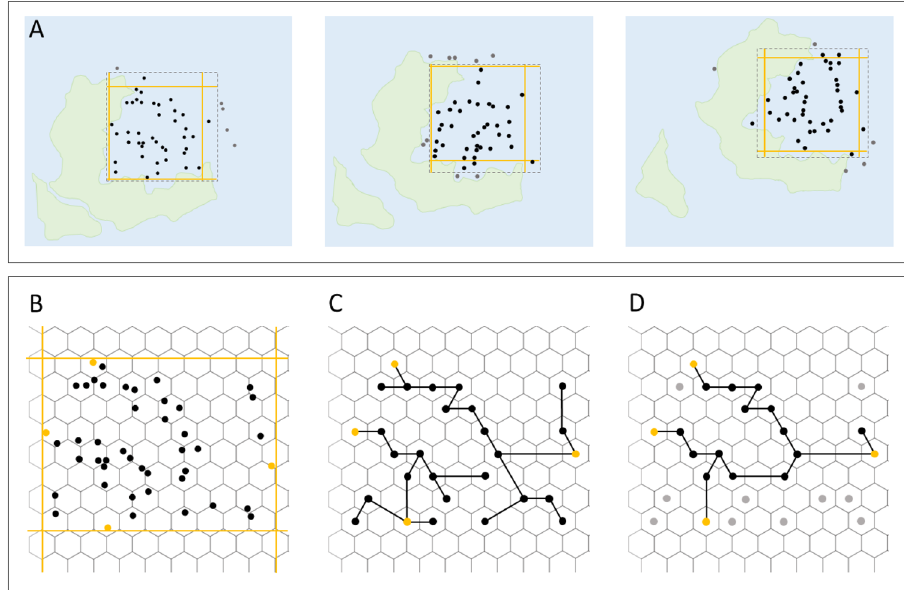
Fig. 8 Component steps of our spatial standardisation work fl ow. A A spatial window (dotted lines) is used to demarcate the spatial region of interest, which may shift in a regular fashion through time to track that region. Data captured in each window is clipped to a target longitude – latitude range (orange lines). B The data forming the longitude – latitude extent is marked, then masked from further subsampling. C Data are binned using a hexagonal grid, the tally of occurrences in each grid cell taken, and a minimum spanning tree constructed from the grid cell centres. D The cells with the smallest amount of data are iteratively removed from the minimum spanning tree until a target tree length is